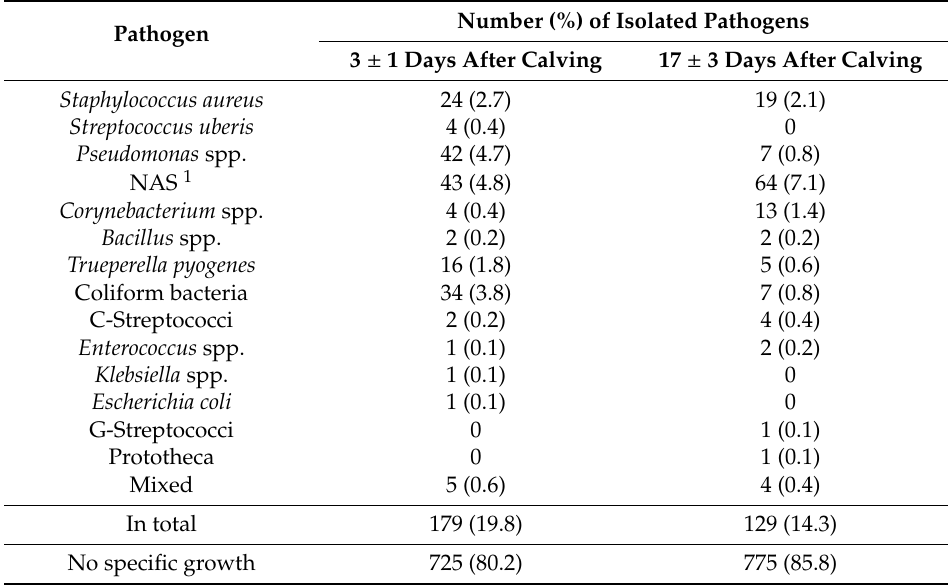
Table 3. Pathogens isolated from quarter milk samples 3 ± 1 and 17 ± 3 days after calving.